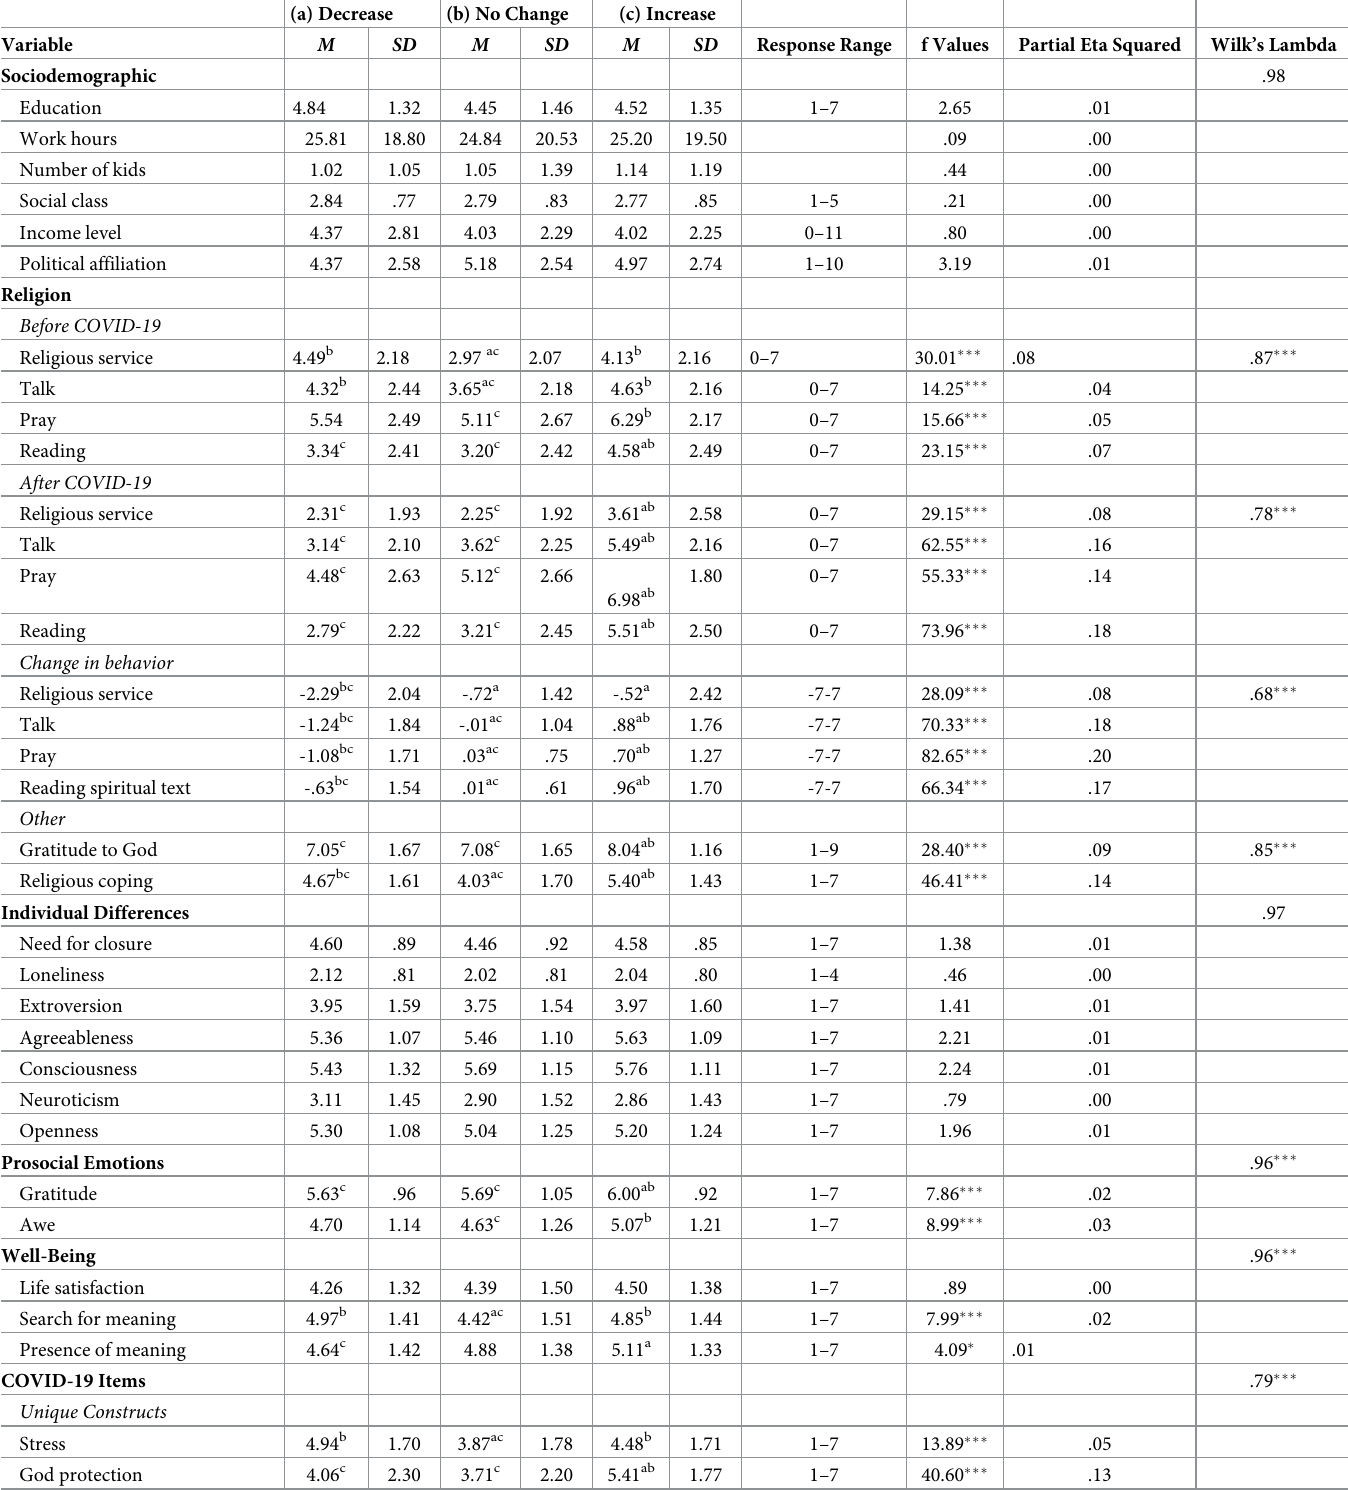
Table 1. MANOVA results for changes in religious